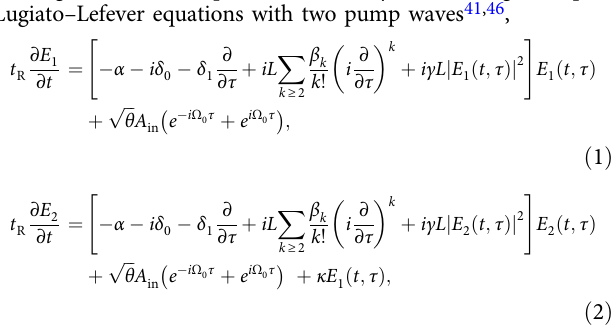
shows the measured temporal interference signal (green) along with DOPO 1 (red) and DOPO 2 (blue), for three different heater between the two DOPOs, corresponding to in-phase operation ( ϕ out = 0) [Fig. 4 (top)]. For 54.2 mW of heater power, we observe destructive interference [Fig. 4 (middle)] corresponding to out-of-phase operation ( ϕ out = π ). The transition from in- phase to out-of-phase operation occurs at 50.2 mW of heater power, and we observe both constructive and destructive inter- ference [Fig. 4 (bottom)]. Moreover, we observe in-phase operation ( ϕ out = 0) for heater powers below 48.3 mW and out-of-phase operation ( ϕ out = π ) for powers above 54.2 mW, indicating that the DOPOs above threshold operate in-phase or out-of-phase for a continuous range of coupling phases ϕ c . The convergence time of the DOPO is well within the pump pulse duration of 310 ns. For comparison, we perform interference measurements on a similar device with no coupling waveguide between DOPO 1 and DOPO 2 and verify that there is no phase correlation between the two signals (see Supplementary Note 3).